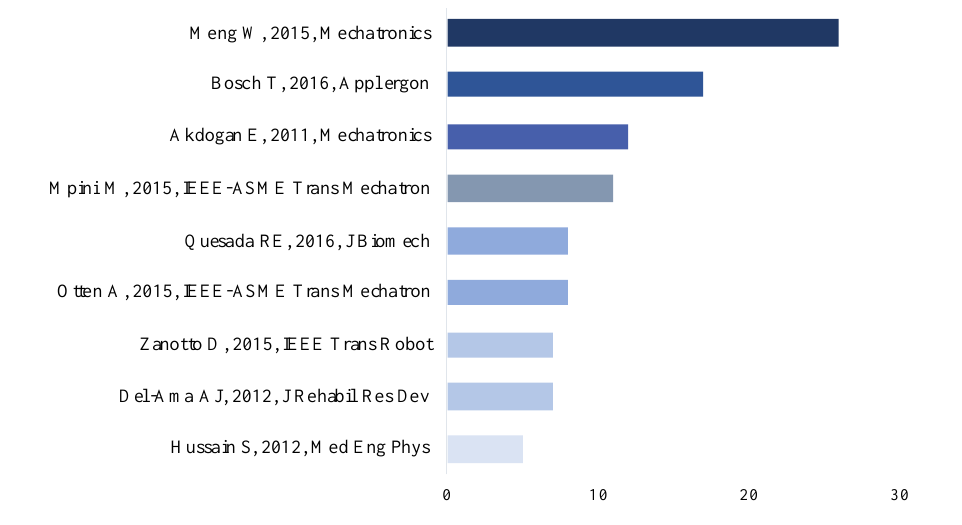
Figure 10. Most cited documents. The United States is the most productive country (14 documents), followed by the United Kingdom (13 documents) and China (7 documents) (see Figure 11).